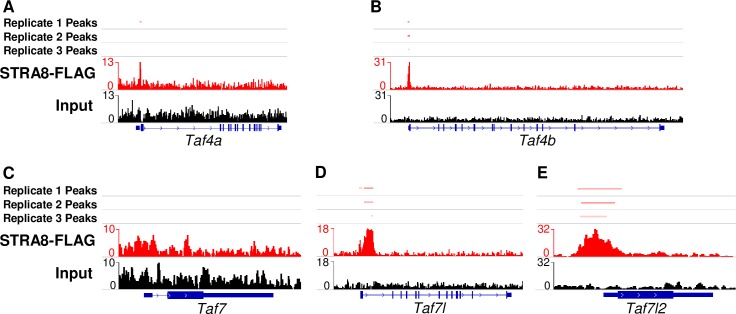
STRA8 ChIP-seq signal shows STRA8 binding at or near the promoters of TFIID subunits.(A-E) ChIP-seq signal from STRA8-FLAG samples and the peaks called (red) in comparison to input DNA (black) for Taf4a (A), Taf4b (B) Taf7 (C), Taf7l (D), and Taf7l2 (E).